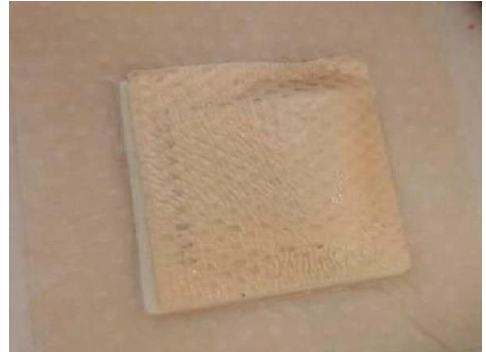
Figure 5. Securing the smart patch .